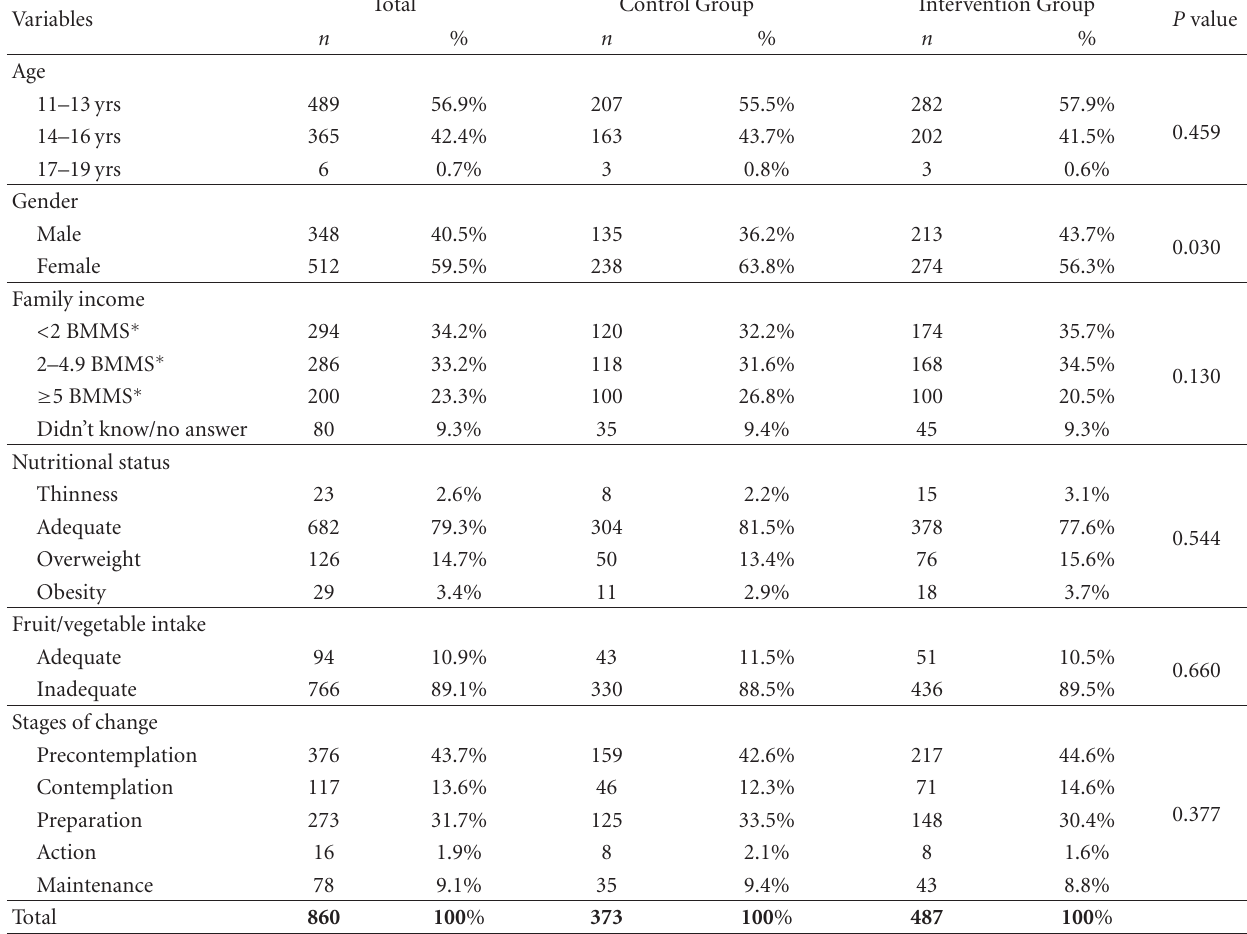
Table 1: Comparability between the intervention and control groups, regarding baseline